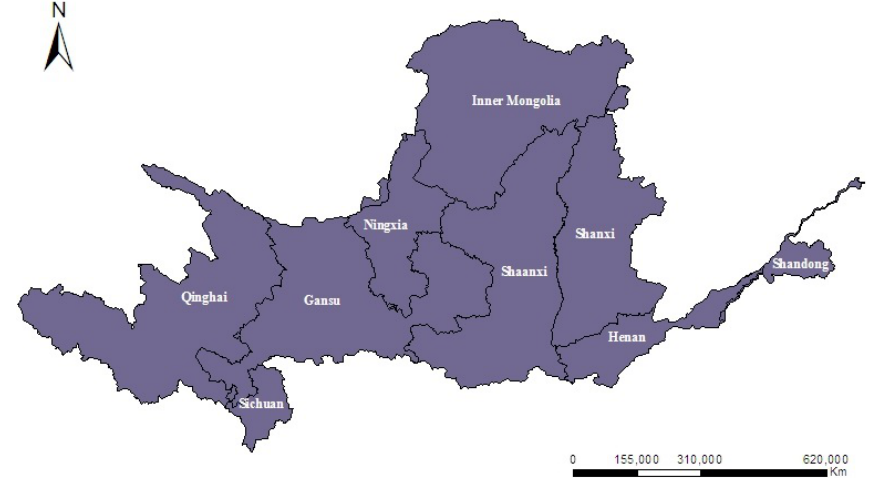
Fig. 2. Administrative regions to be evaluated in the Yellow River basin.